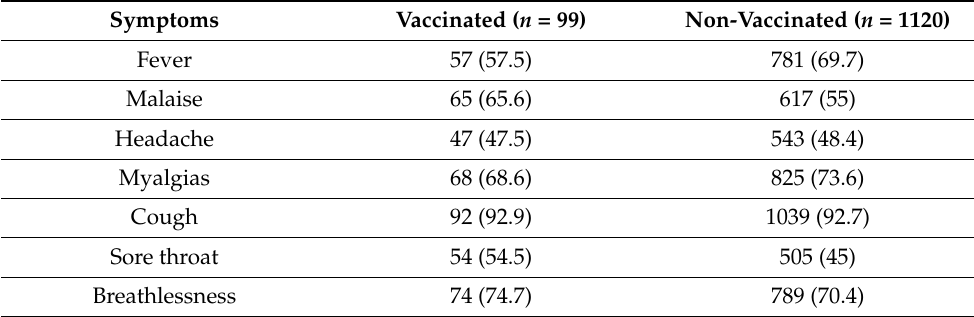
Table 1. Clinical symptoms of participants at